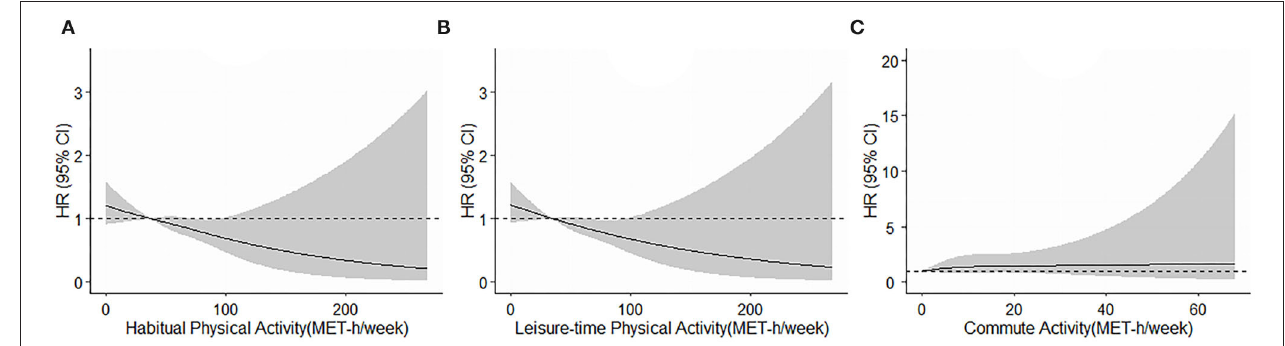
FIGURE 2 | (A–C) Restricted cubic splines of the relationship of all all-cause mortality with habitual physical activity, leisure-time physical activity, and commute activity. Potential non-linear relationships were examined using restricted cubic splines (knots on the 50th, 75th, and 95th percentiles), with hazard ratios ( HRs ) based on cox regression models. HRs with 95% confidence intervals ( CIs ) were plotted for each unit of the exposure against the median of the first tertile. The dash line represents the HR equal to 1. The HRs was adjusted for age, sex, education, marital status, smoking, alcohol drinking, body mass index, hypertension, diabetes, dyslipidemia, chronic obstructive pulmonary disease, cardiovascular disease, leisure-time physical activity (for commute activity), and commute activity (for leisure-time physical